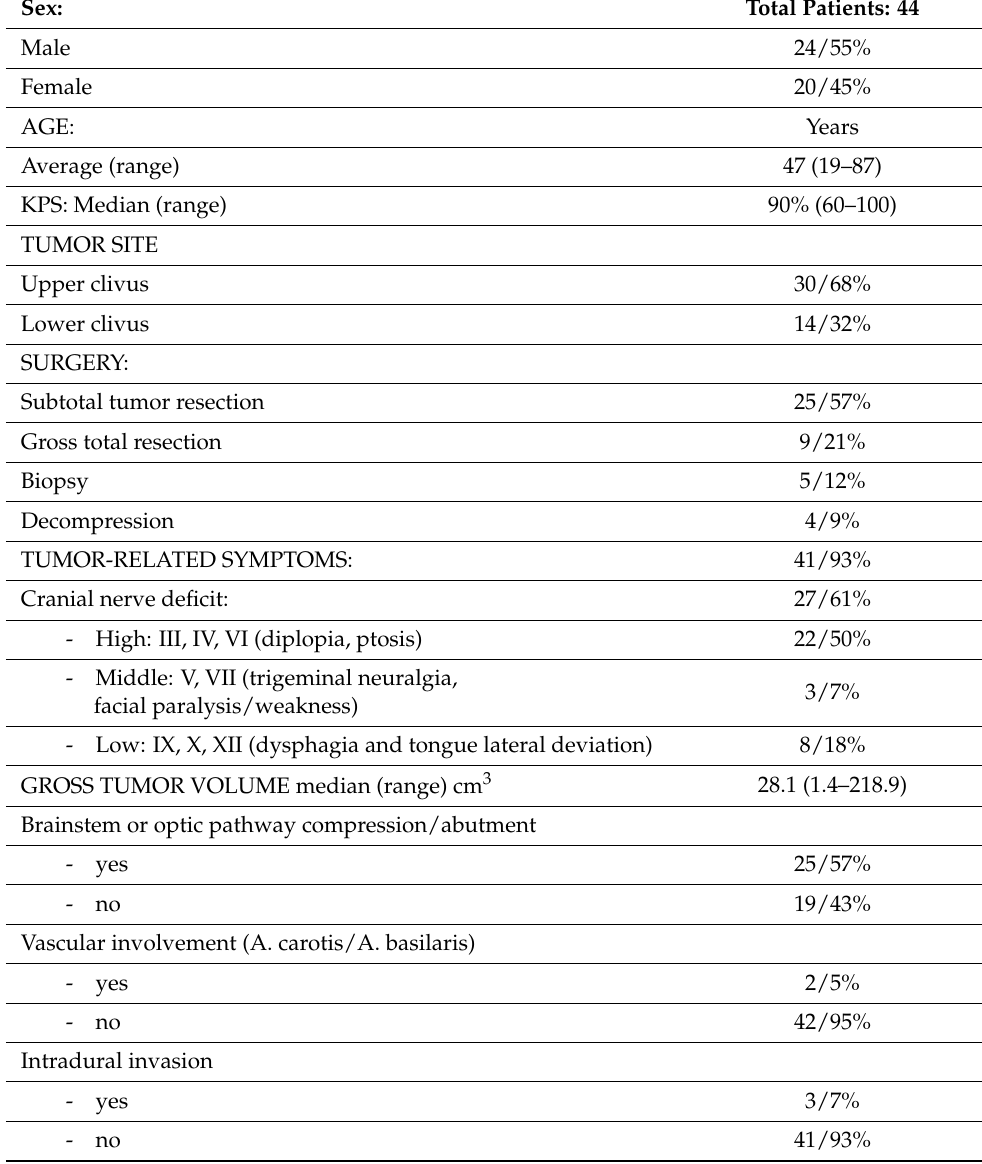
Table 1. Patients and disease